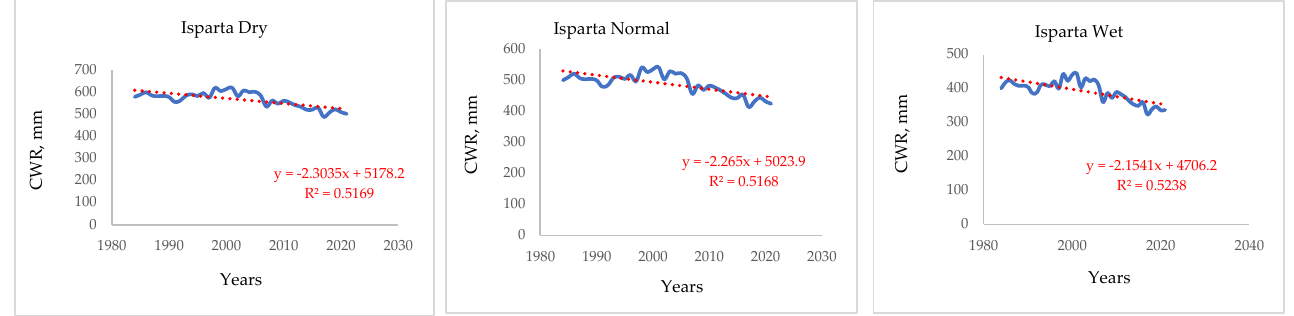
Figure 4. Crop water requirements of apples according to dry, normal and wet years, mm. CWR: crop water requirement, mm; 3: three-year moving average; 5: five-year moving average.